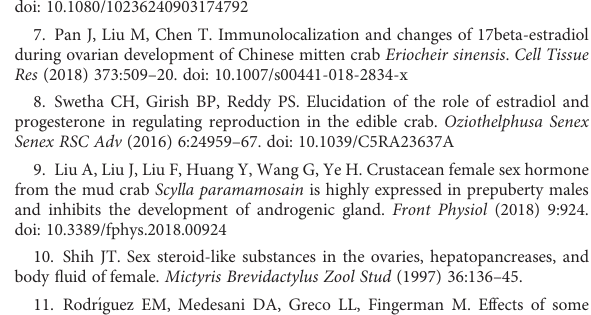
SUPPLEMENTARY FIGURE 1 Multiple sequence alignment of the StAR3 amino acid sequence among species. The conserved functional structures (MENTAL and START domains) are marked in box (A) . Multiple sequence alignment of the 3 b HSD amino acid sequence among species. The conserved functional structure (3 b _HSD domain) is marked in box (B) . Multiple sequence alignment of the 17 b HSD8 amino acid sequences among species. The conserved functional structure (adh_short_C2 domain) is marked in box (C) . Multiple sequence alignment of the ERR amino acid sequence among species. The conserved functional structures (zf-C4 and Hormone_recep domains) are marked in box (D) . Identical residues are shown as white letters with red background, and similar residues are shown as black letters with yellow background. SUPPLEMENTARY FIGURE 2 17 b HSD8a (A, B) and 17 b HSD8b (C, D) sense probe hybridization were used as control of the antisense probe hybridization. Whole-mount immunohistochemistry: pre-immune serum (E) was applied as control of the 17 b HSD8 speci fi c antibody. Scale bars = 100 m m. SUPPLEMENTARY FIGURE 3 No notable abnormalities were observed in the length and abundance of ovigerous (A*) and plumose setae (B*) , wet weight and size of spermathecae (C*) , and the presence, position and size of gonopores (D*) after multiple injections of CFSH-dsRNA. Scale bar = 5